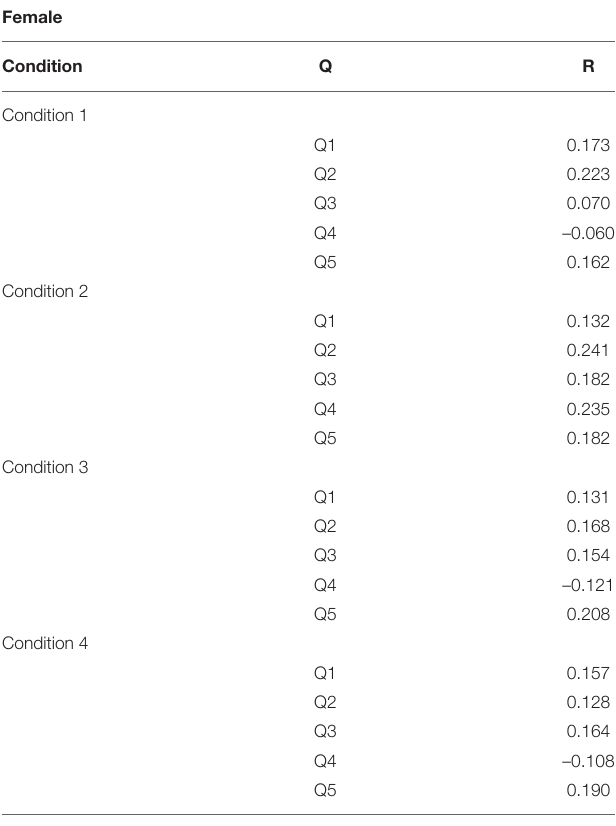
TABLE 11 | Correlation coefficients between the age of participants and each of their